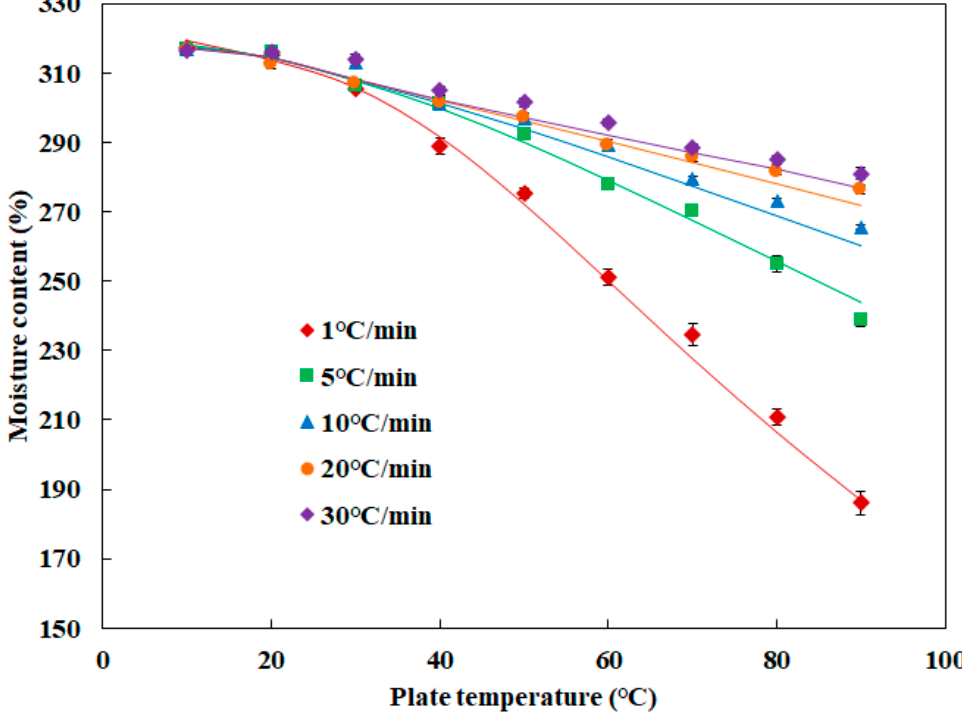
Figure 3. Changes in moisture content of Alaska pollock surimi paste during temperature sweep in the dynamic rheometer system under cone-plate geometry. Symbols and lines represent experimental data and simulation results, respectively.